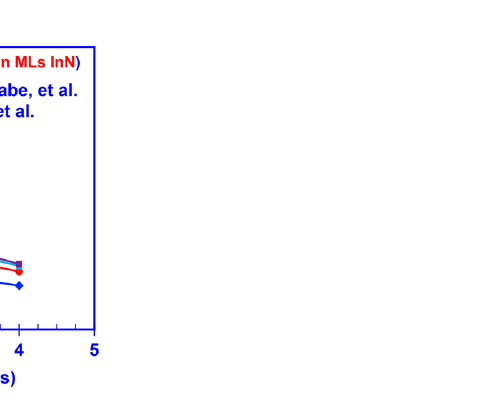
Figure 3. Miniband structures of the InGaN digital alloy formed by: ( a ) 1 ML GaN with 1 ML InN binary layers, ( b ) 1 ML GaN with 4 MLs InN binary layers, ( c ) 4 MLs GaN with 1 ML InN binary layers, and ( d ) 4 MLs GaN with 4 MLs InN binary layers.